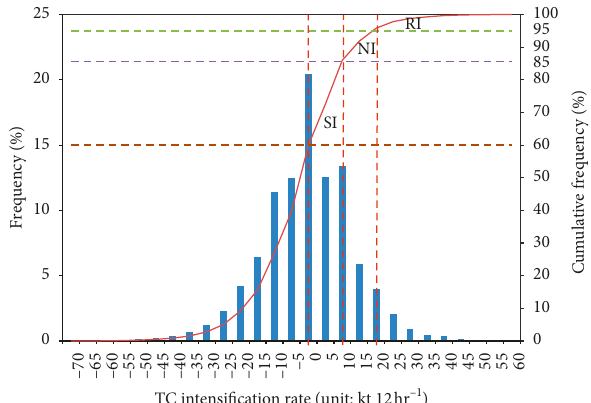
Figure 1: Frequency distribution and cumulative frequency dis- tribution of the 12hr intensity changes of all TCs in the 1995–2015 in Northwest Pacific basin (10156